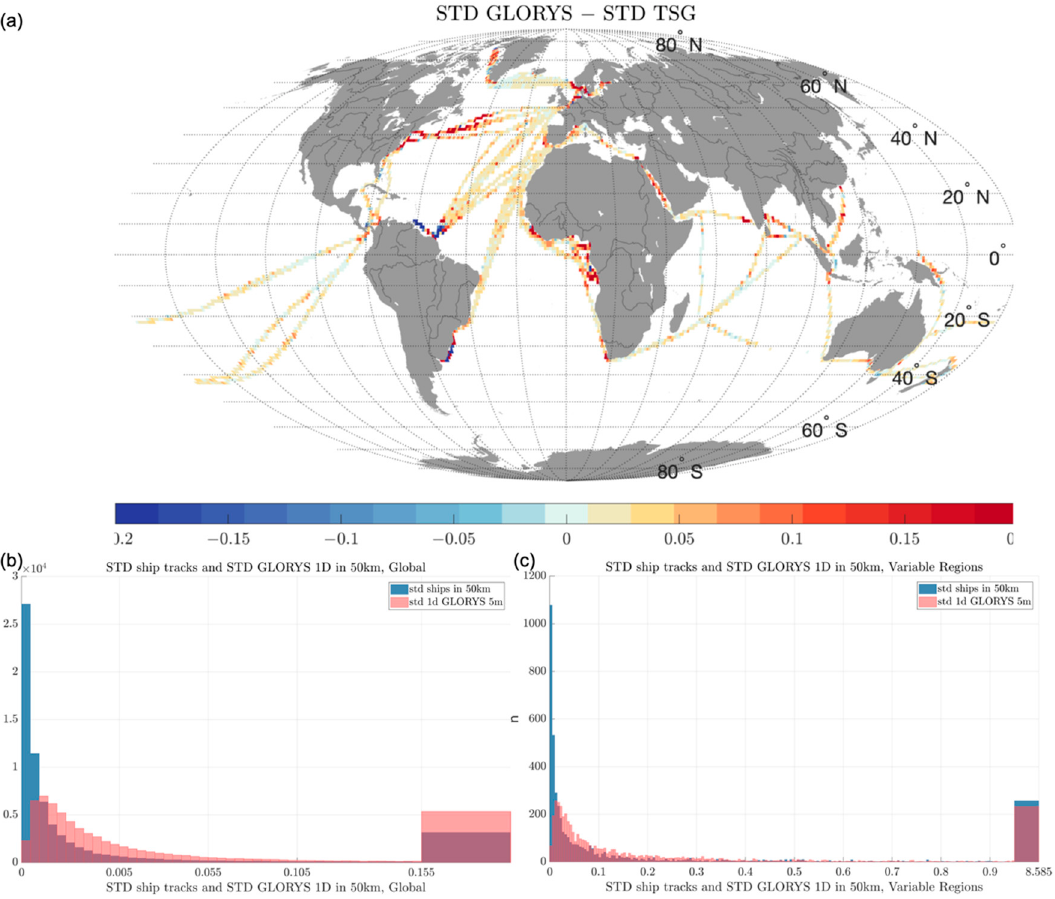
Figure 8. Comparison between GLORYS data standard deviation and in-situ variability. ( a ) Merchant ships averaged over 1° boxes; ( b , c ) histograms of Merchant ships STD (blue) and GLORYS STD (red) ( b ) globally, and ( c ) in very variable areas defined Table 1.